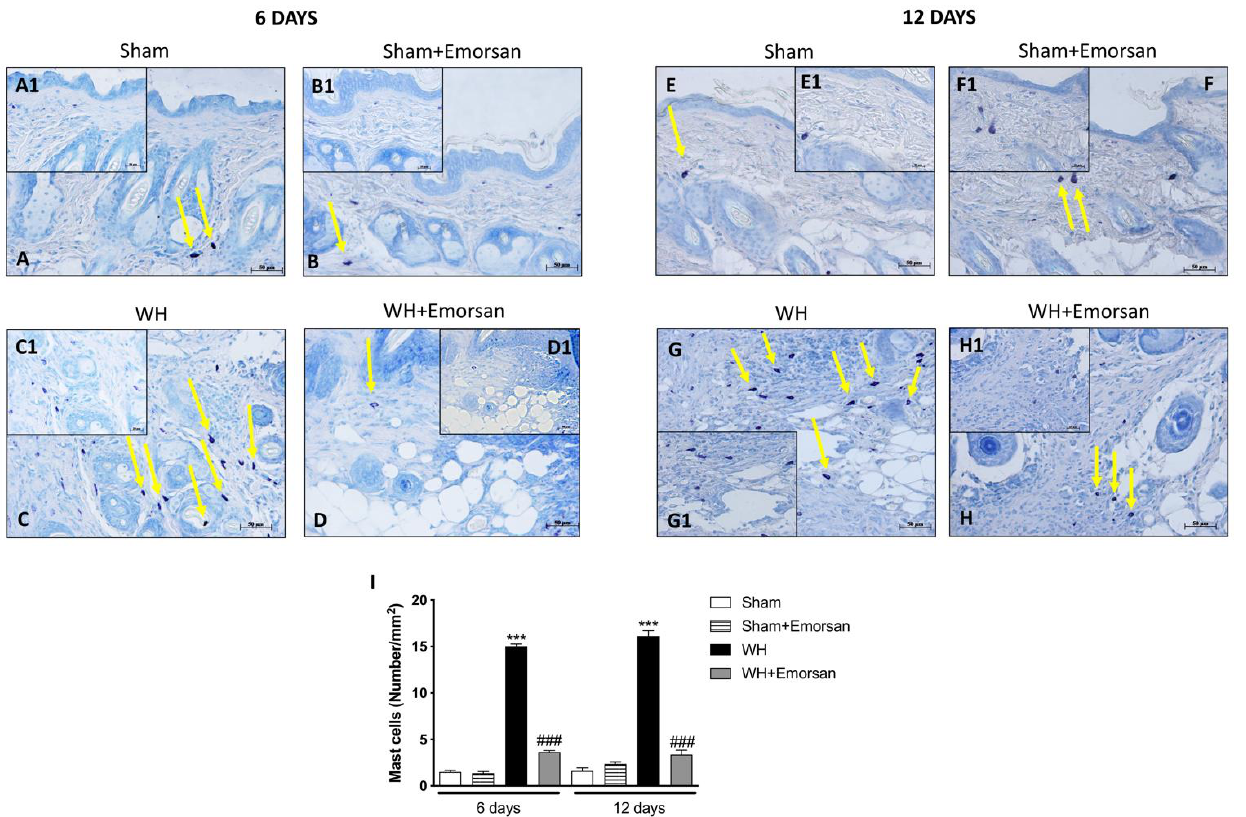
Figure 4. Effect of Emorsan ® Gel on mast cells in epidermal tissues after WH induction. A high degree of mast cells was found in mice with WH ( C , C1 , G , G1 ,score I ) compared to control animals ( A , A1 , B , B1 , E , E1 , F , F1 ,score I ). However, a decreased number of mast cells was identified in mice topically treated with Emorsan ® at both 6 days ( D , D1 ,score I ) and 12 days ( H , H1 ,score I ). Data are representative of at least three independent experiments. Values are means ± SEM. One-Way ANOVA test. *** p < 0.001 vs. corresponding Sham; ### p < 0.001 vs. corresponding WH.